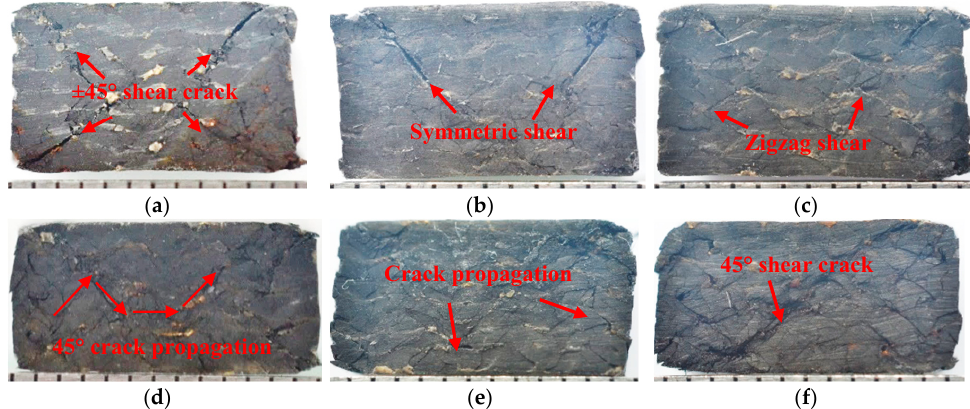
Figure 7. Damage morphologies of specimens with 21° braiding angle at different temperatures: ( a ) 25 °C, ( b ) 60 °C, ( c ) 90 °C, ( d ) 120 °C, ( e ) 150 °C, and ( f ) 180 °C.